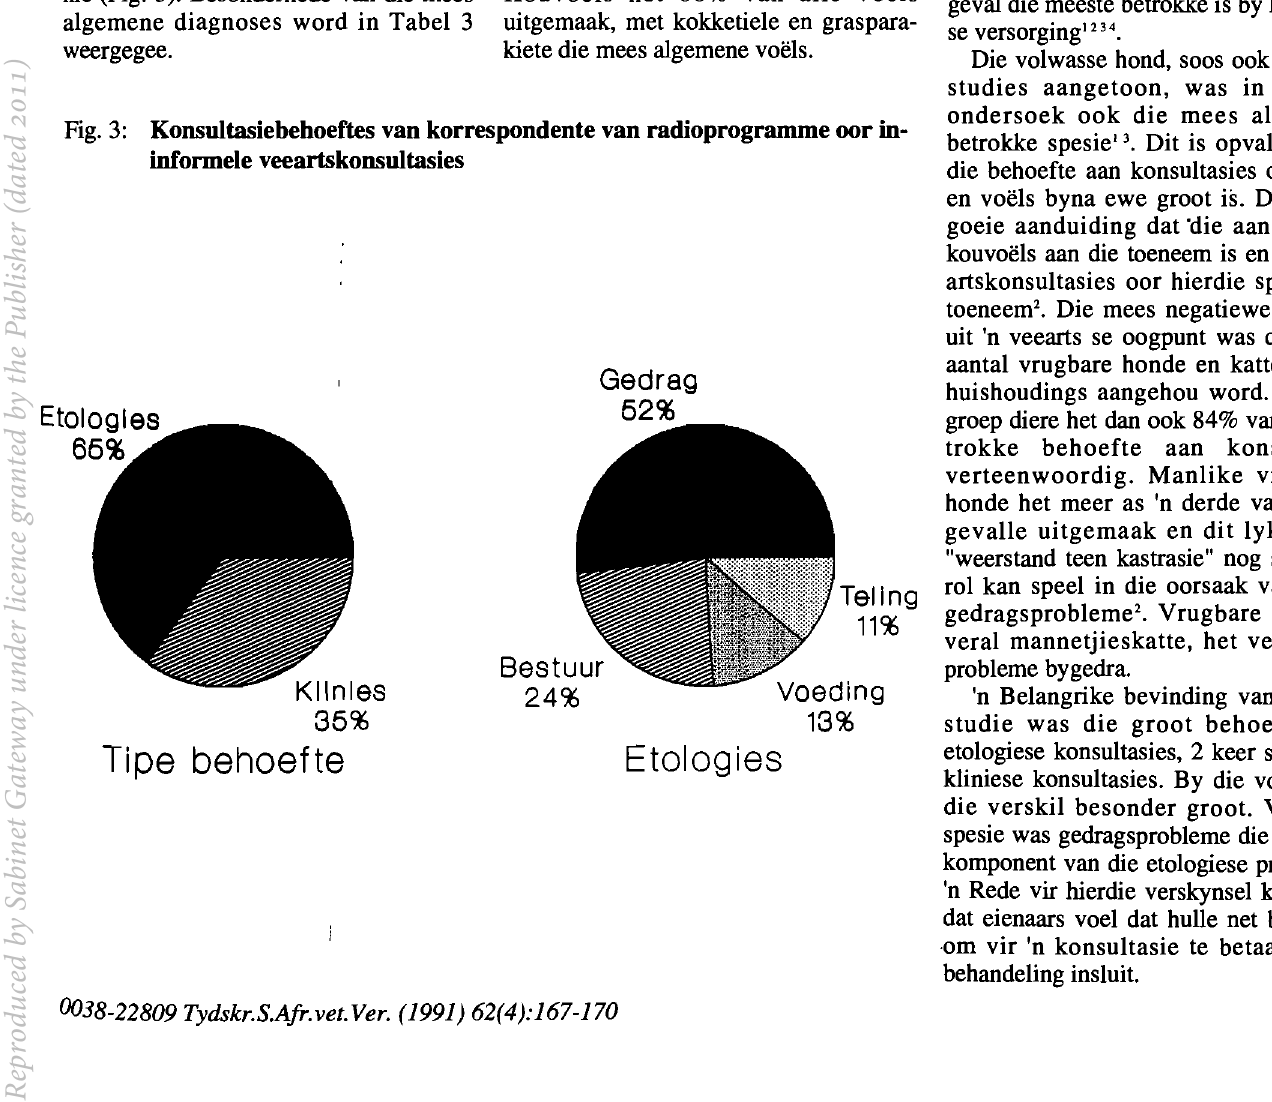
Fig. 3: Konsultasiebehoeftes van korrespondente van radioprogramme oor in informele